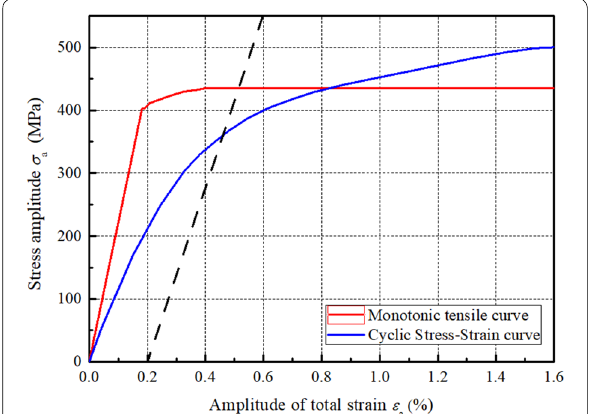
Figure 9 Monotonic tensile and cyclic stress–strain curves of the weathering steel